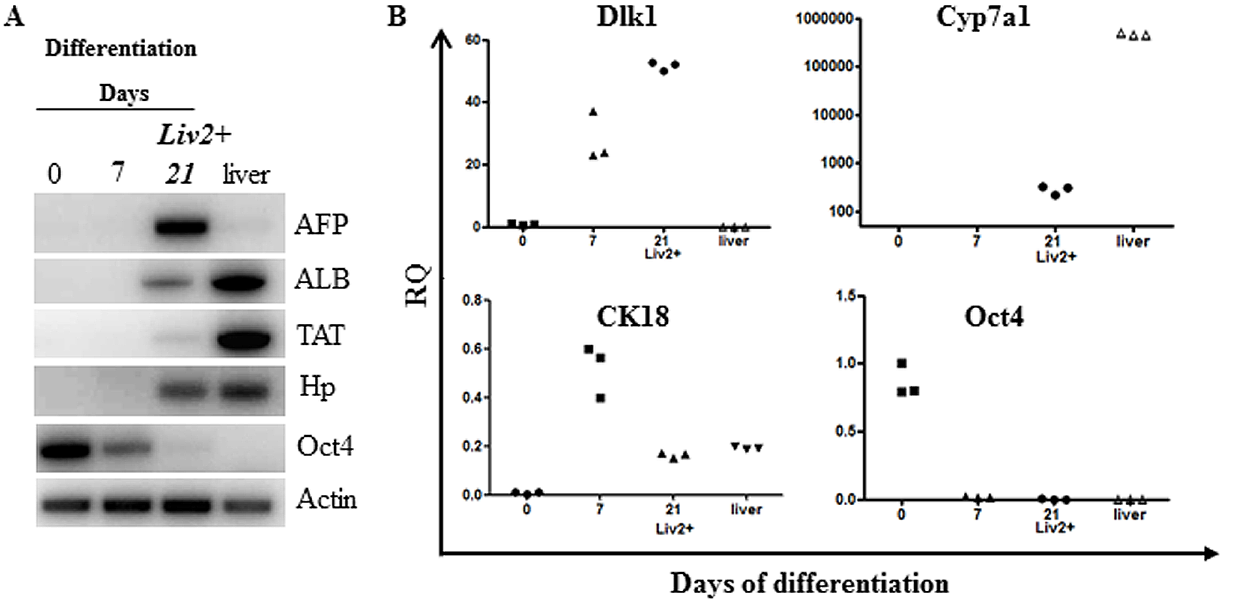
Fig 2. Analysis of hepatocyte-specific gene expression in Liv2-sorted GPSC-derived hepatocytes. A. RT-PCR analysis of liver-specific gene expression. RNA samples were extracted from undifferentiated GPSCs cells (0 day), differentiating EBs (7 days), Liv2-sorted cells (21 days) and adult liver. Actin served as an internal standard. Data shown are representative of 3 independent experiments. B. qRT-PCR was also used to assess the expression of Dlk1, Cyp7a1, CK18 and Oct4 in Liv2-sorted GPSCs during hepatocyte differentiation (n = 3). The relative quantity (RQ) with respect to gene expression in undifferentiated GPSCs (differentiation Day 0) is shown and values have been normalized to 18S expression (n = 3). Abbreviations: ALB, albumin; AFP, alpha fetoprotein; TAT, tyrosine amino transferase; Hp, haptoglobin; Dlk1, Delta-like 1 homolog; Cyp7a1, cytochrome P450 7a1; CK18, cytokeratin 18.